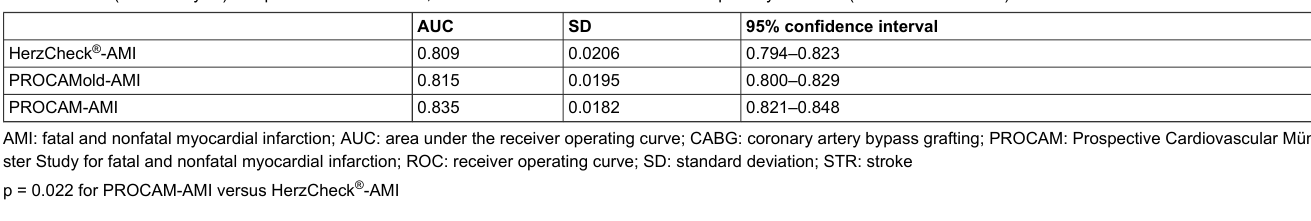
Table 5: Discrimination (ROC analysis) comparison of HerzCheck, AGLAold and AGLA to detect secondary outcome (all cardiovascular events). HerzCheck®-AMI